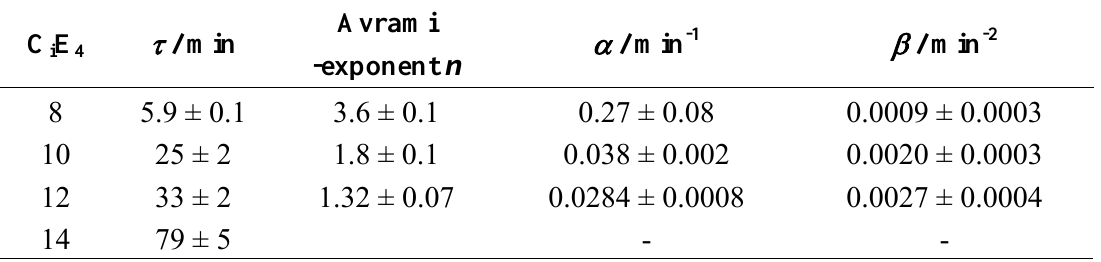
Table 1. Kinetic parameters for the ME → LC phase transition. The definitions are given in the